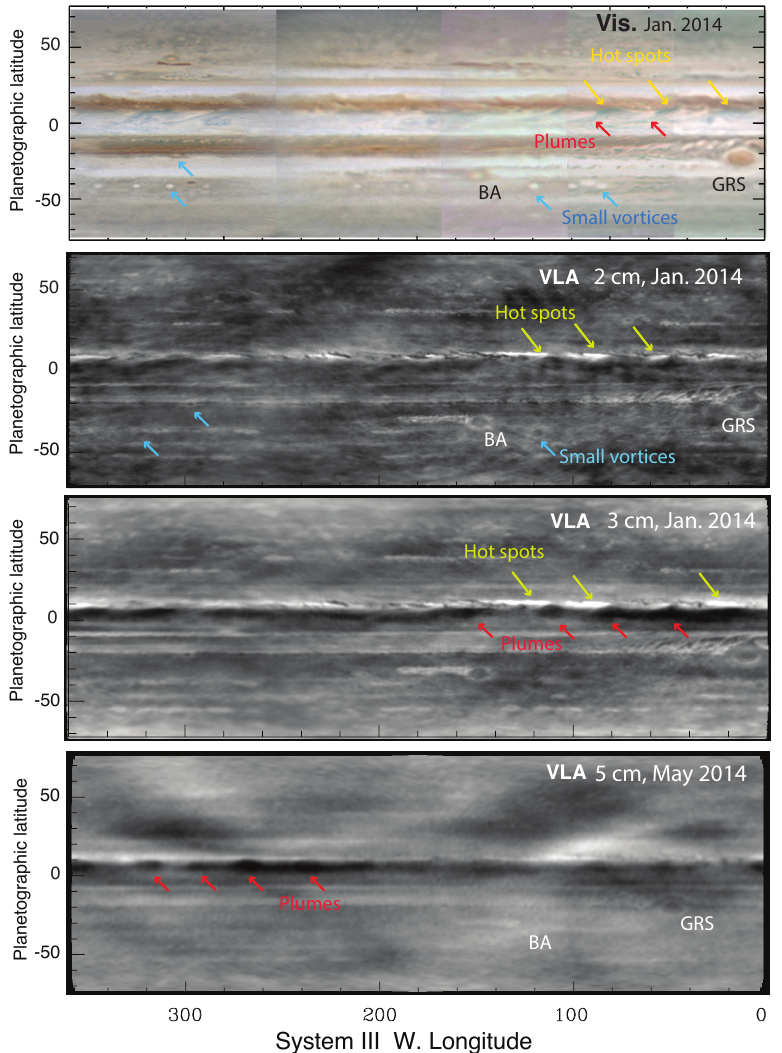
Figure 7. Longitude-resolved radio maps after subtraction of a uniform limb-darkened disk at 2-cm (12–18 GHz), 3-cm (8–12 GHz), and 5-cm (4–8 GHz) bands, as indicated in the